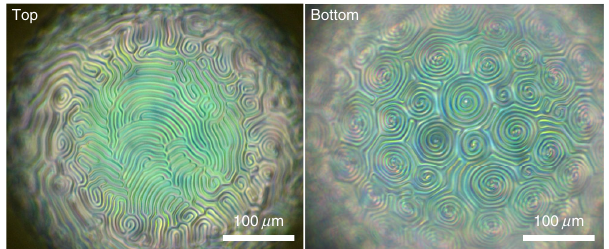
FIG. 6. The bent state can coexist with the FCD state in the CLC shell with heterogeneous thickness. A CLC shell with 0 mM SDS, 1 M NaCl, and 1% PVA in the inner water phase begins to swell in an outer water solution with 7 mM SDS, 0.1 M NaCl, and 1% PVA. Thickness variation in the CLC shell shows that thinner regions have stripes from bent cholesteric layers (left panel), expressing the bent state, while thicker regions in the back of the drop have FCDs (right